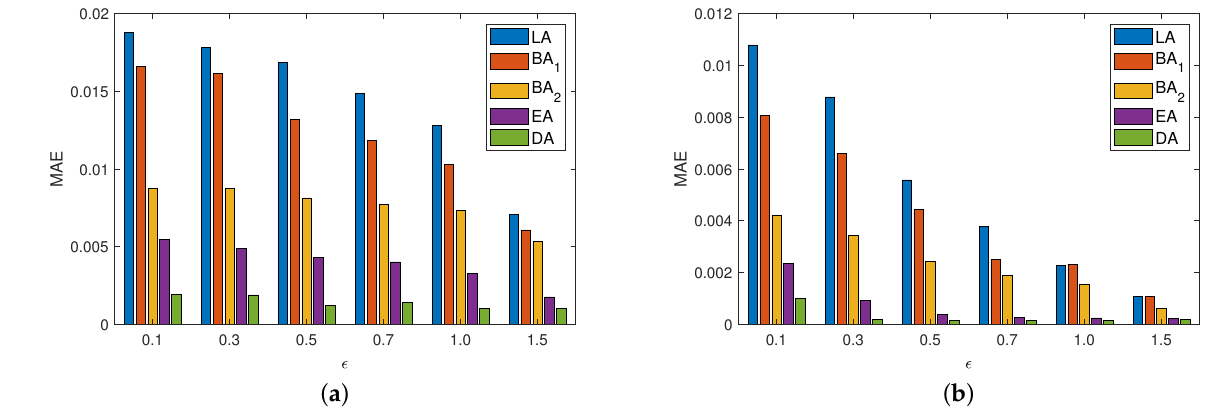
Figure 3. MAE for varying (cid:101) . ( a ) Seoul Metro dataset; ( b ) Synthetic